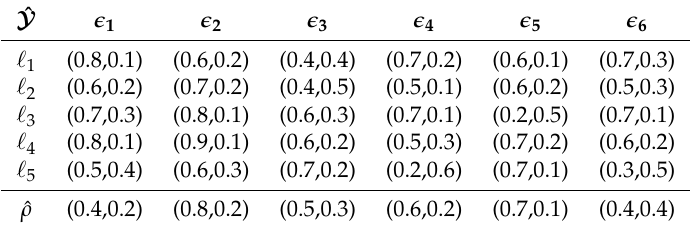
Table 1. The GIFSS ( ˆ F , ˆ A , ˆ ρ ) .